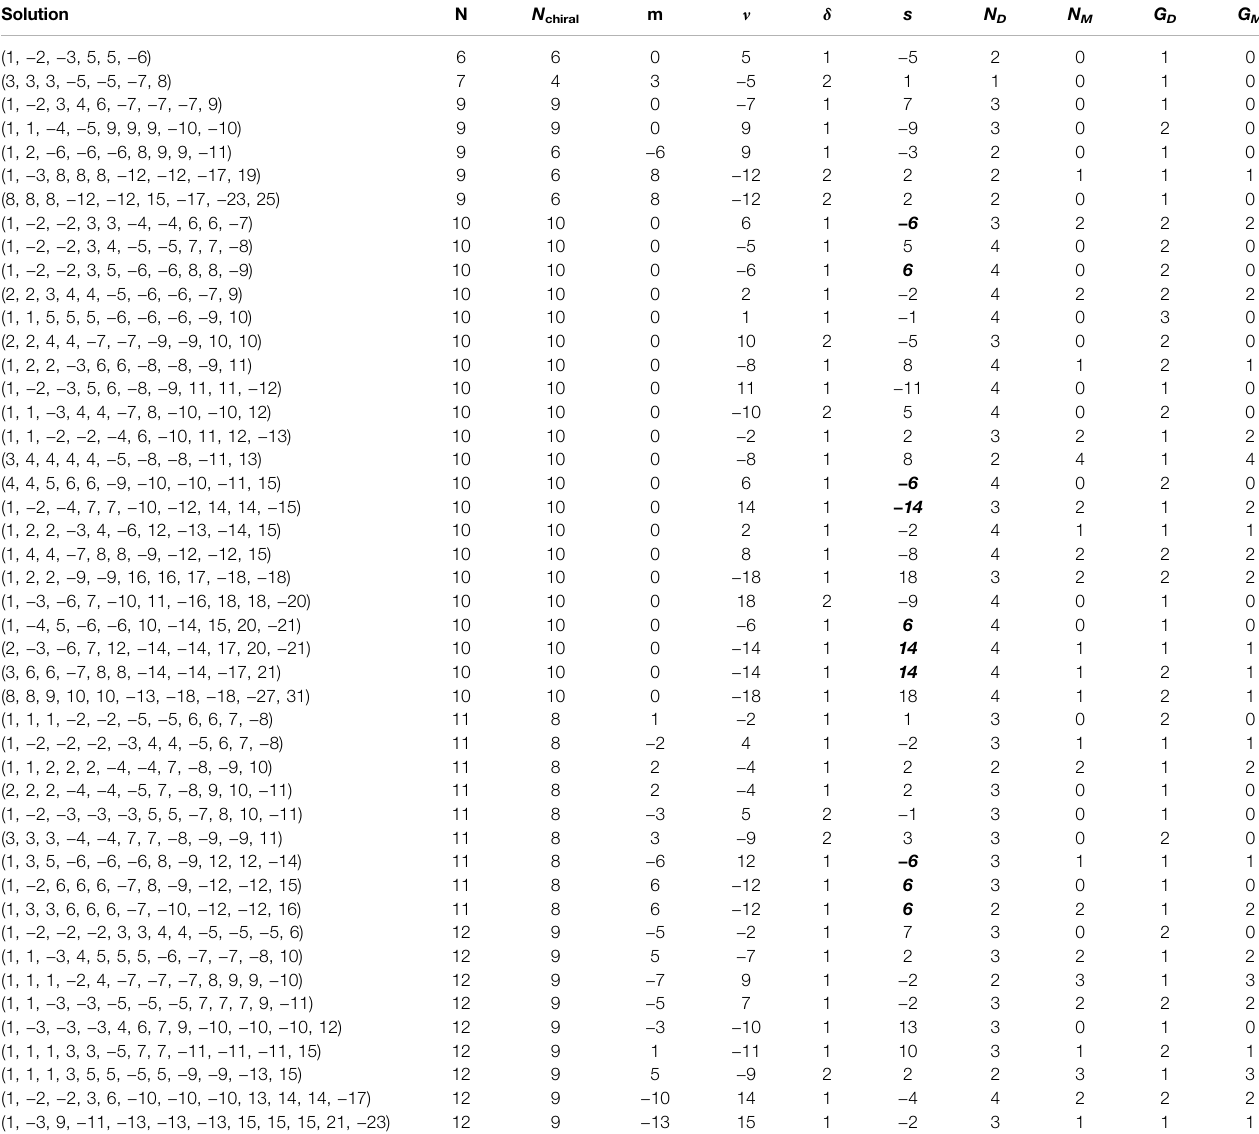
TABLE 1| SetofchargessatisfyingtheDiophantine Eq.1 togetherwiththeconditionsenumeratedinthetext,forsolutionswith N chiral massivefermions,includingtheDiracneutrinos massesallowedbytheeffectiveoperatorof d =4+ δ ,thesolutionwithunconditionalstabilitythrough Z | s | ishighlightedwithaboldfontforthechargeof| s |= 6 , 14 . N D and N M are the number of massive Dirac and Majorana SM-singlet fermions in each solution, while G D and G M are the corresponding number of maximum generations in the set. Solution N N chiral (1, − 2, − 3, 5, 5, −